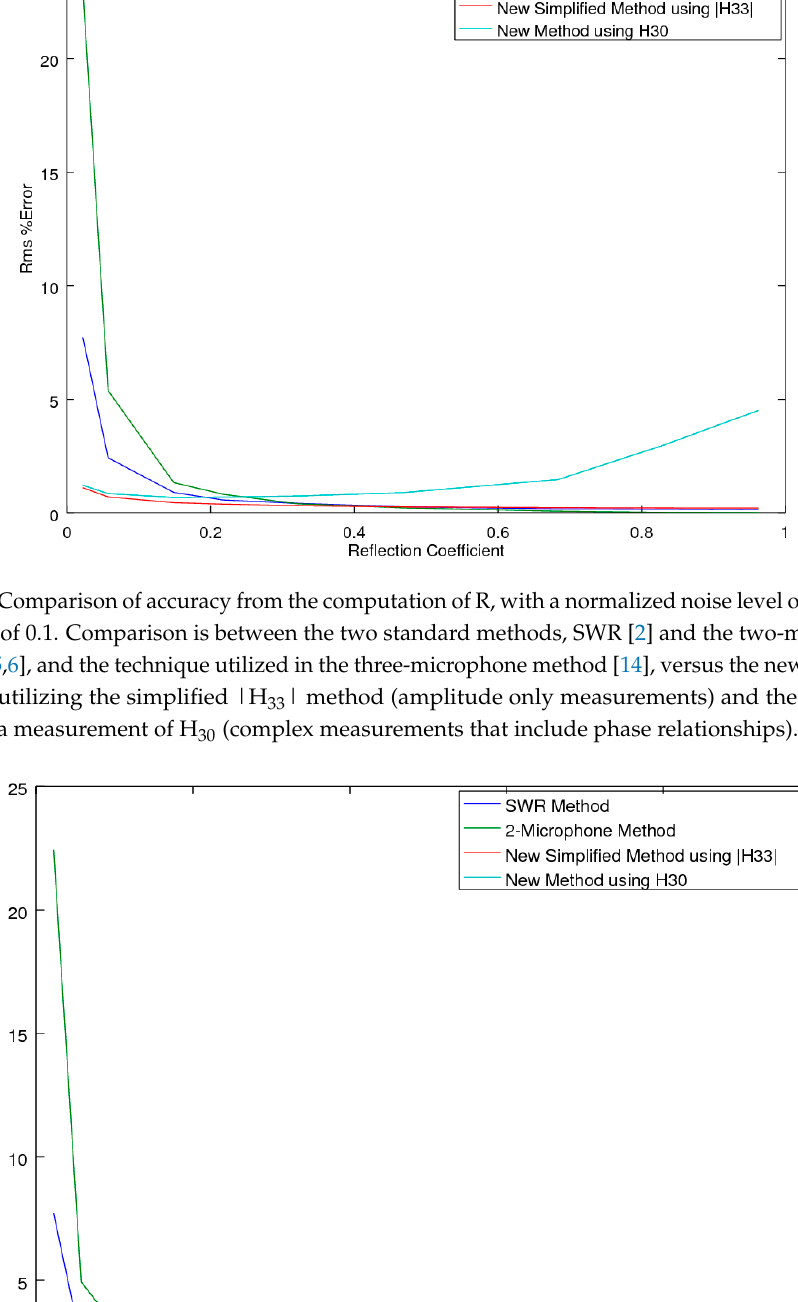
Figure 4. Comparison chart depicting pressure inside the tube with and without noise for two different reflection coefficients R. The large amplitude signal is the response when the sample’s R was 0.99. The low-amplitude signal is the response for a sample with a much lower R of 0.05. The frequency for this test case was 1000 Hz with a material-relative phase delay of β = 1.20.